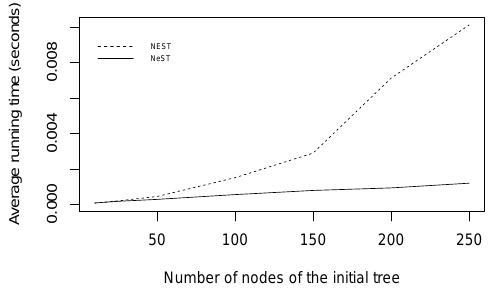
Figure 10. Average running time required to compute the NEST (dashed line) or the NeST (full line) estimated from 3000 simulated